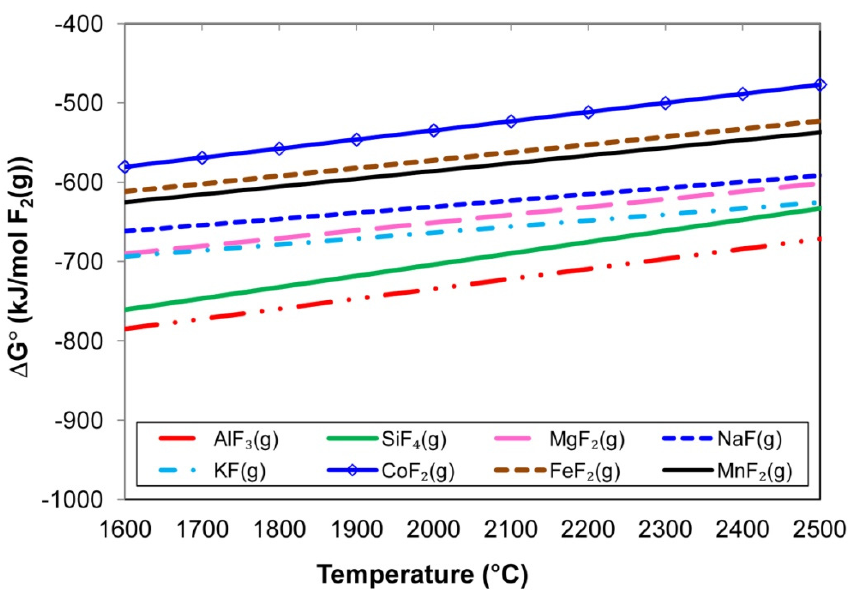
Figure 4. Standard Gibbs free energy for metal vapour and F 2 gas reactions as calculated in FactSage 7.3 [31].